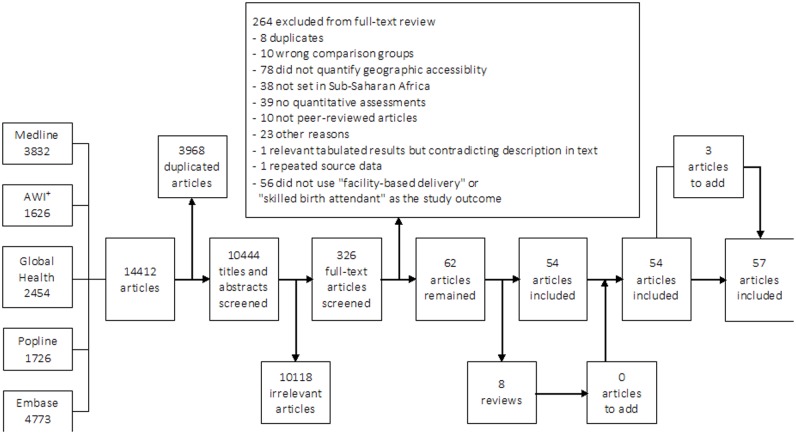
Flow chart of study selection for inclusion in the systematic review.+AWI = Africa Wide Information.